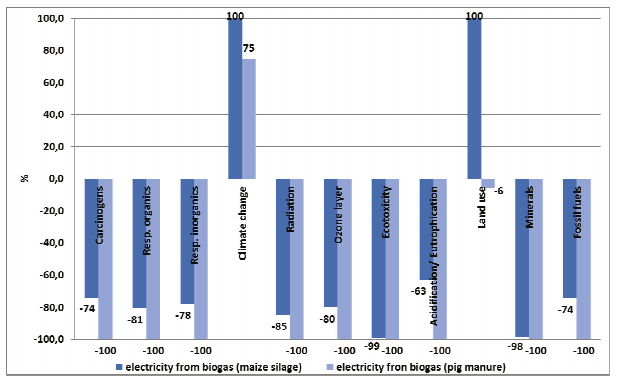
Fig. 3. Results of comparison life cycle assessment of 1 MWh of electrici- ty production from biogas obtain from corn silage, distillery slop and sugar beet pulp ale well as pig manure distillery slop and sugar beet pulp for each impact category in EI-99 method